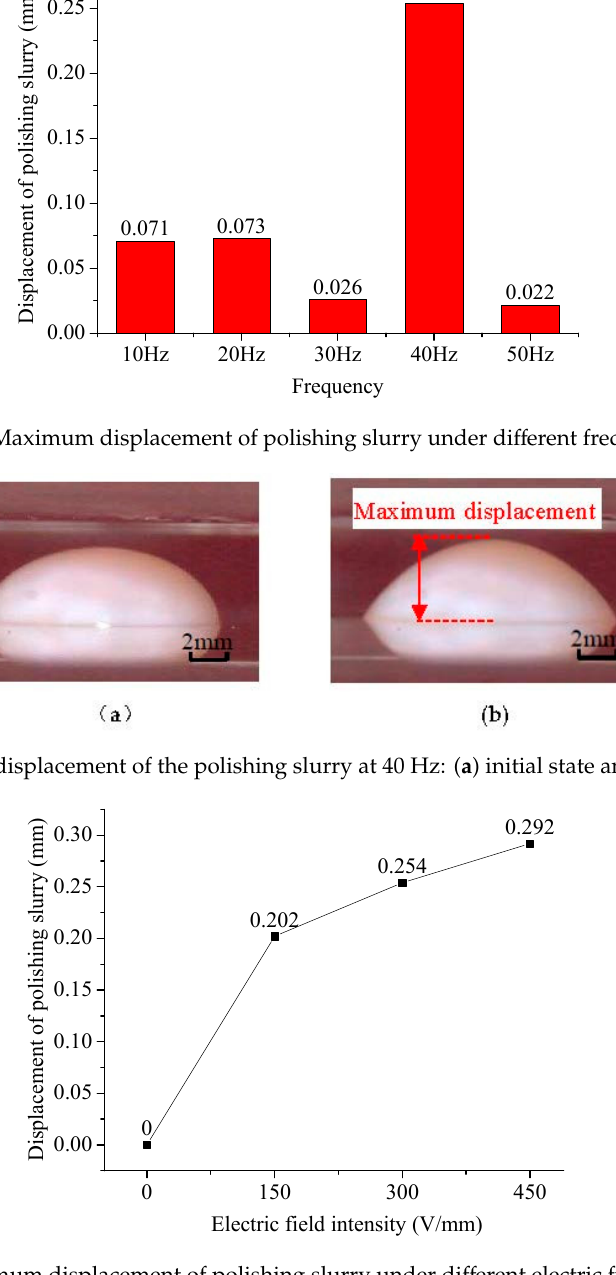
Figure 10. Maximum displacement of polishing slurry under different electric field intensities.